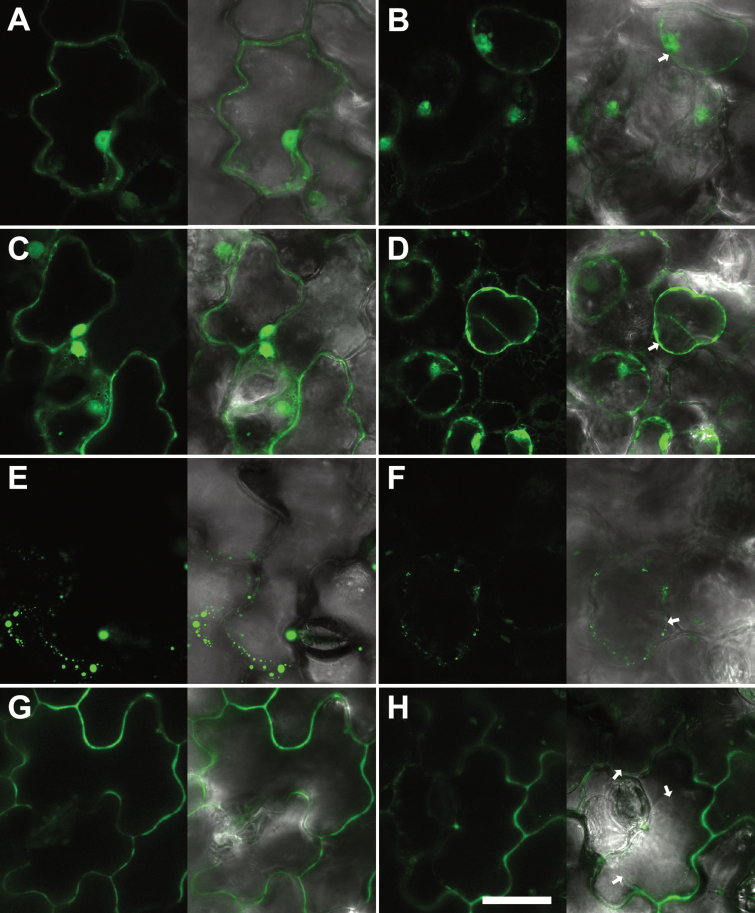
IDL7 is localized to the apoplast. C-terminal GFP tags were cloned in-frame with IDL7, expressed in N. benthamiana epidermal cells under control of the 35S promoter, and analyzed using confocal laser scanning microscopy. The GFP control was localized in the cytosol and the nucleus (A), confirmed by plasmolysis (1 M NaCl, 30 min) (B). (C) IDL7∆SP–GFP was localized in the cytosol, confirmed by plasmolysis (1 M NaCl, 30 min) (D). (E) IDL7FL–GFP was found clogged in vesicular compartments, confirmed by plasmolysis (1 M NaCl, 30 min) (F). (G) IDL7∆C–GFP was localized in the apoplastic space, confirmed by plasmolysis (1 M NaCl, 30 min) (H). Arrows indicate plasmolysed plasma membrane. Scale bar=20 ìm.